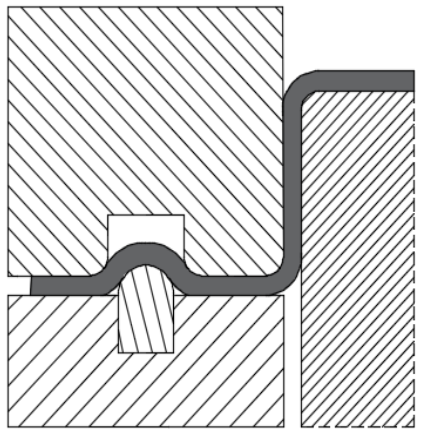
Figure 3. Die drawing bead structure diagram.